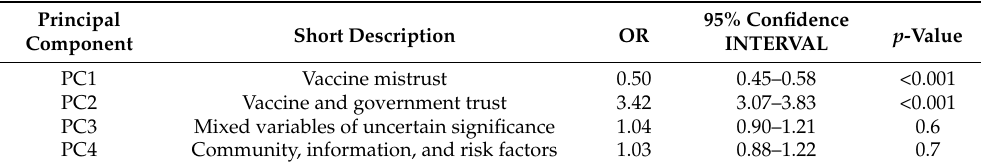
Table 1. Logistic regression results of individual principal components and their relationship to receiving the COVID-19